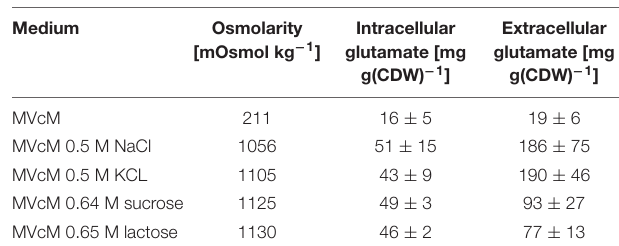
TABLE 1 | Intracellular L-glutamate content of Bacillus methanolicus MGA3 and of supernatants of cells grown in MVcM supplemented with either ionic or non-ionic